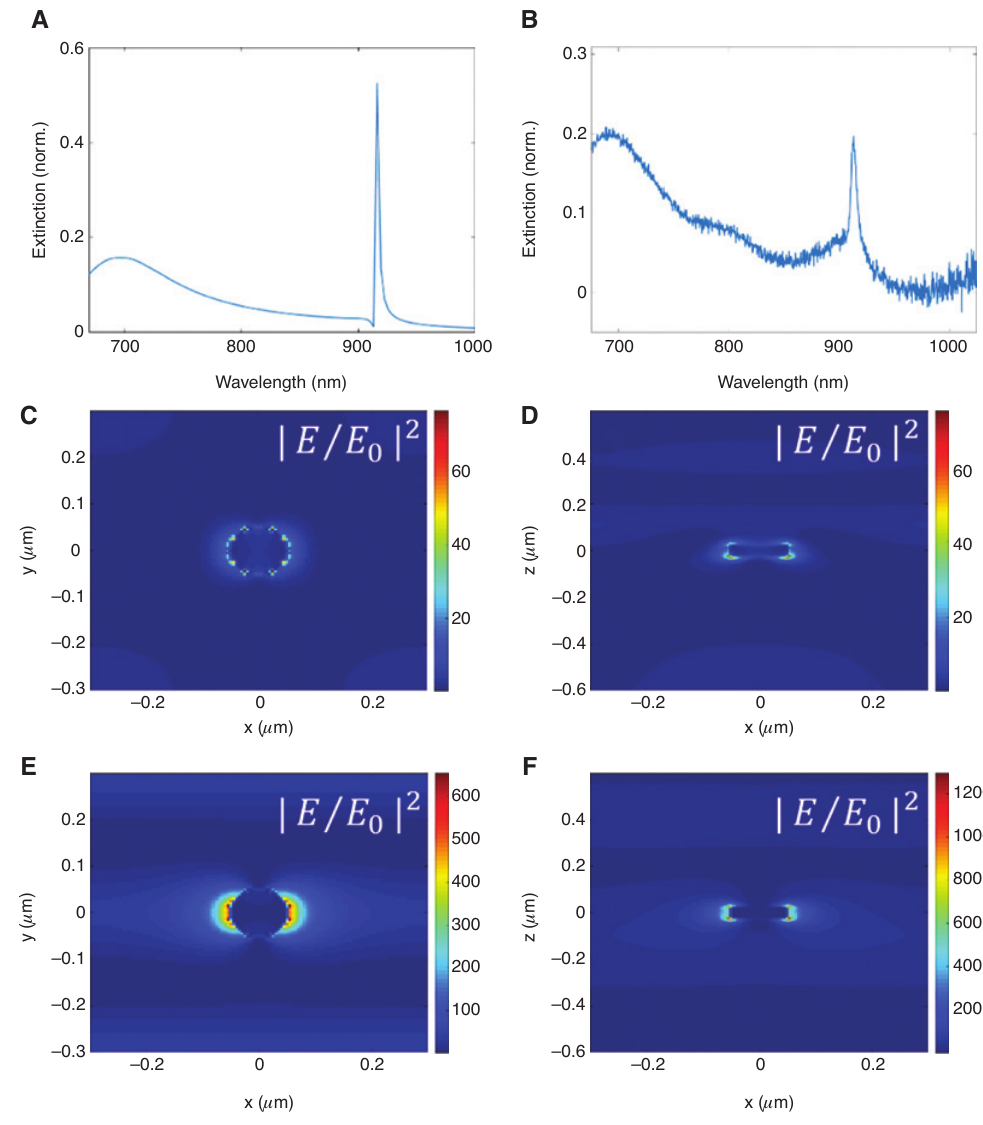
Figure 5: FDTD simulation results for gold. (A) Simulated transmission spectrum and (B) measured spectra at k 690 nm crosscuts in the xy-plane (C) and xz-plane (D). Electric field intensity distribution at resonance at 916 nm crosscuts in the xy-plane (E) and xz-plane